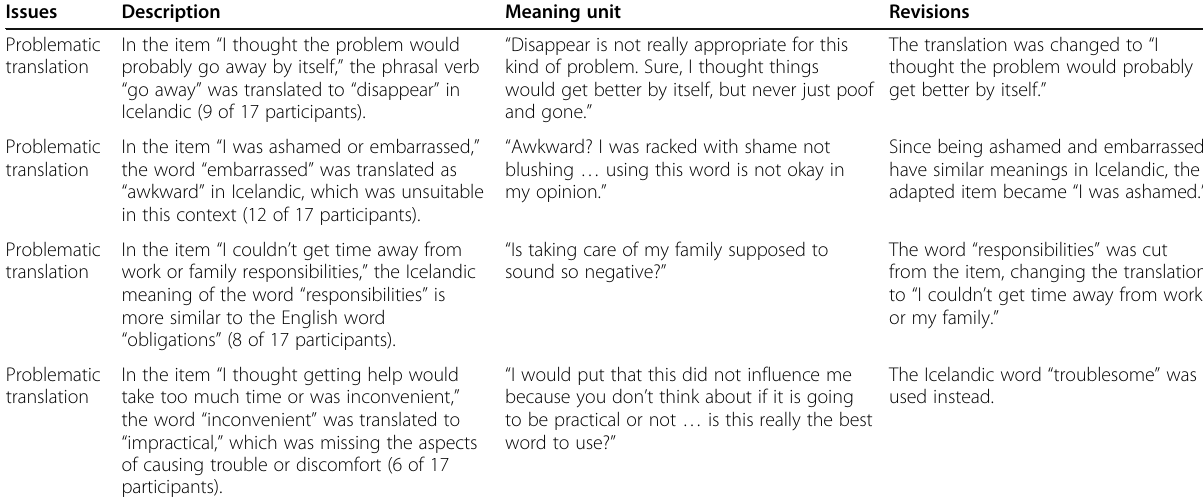
Table 5 Examples of translation issues identified